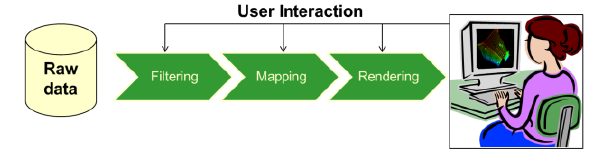
Figure 1. The Visualization Pipeline.